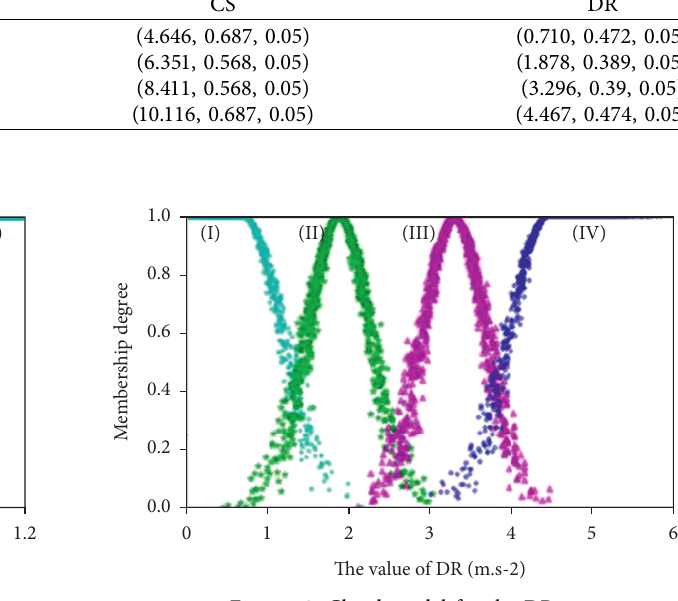
Figure 6: Cloud model for the TTC.